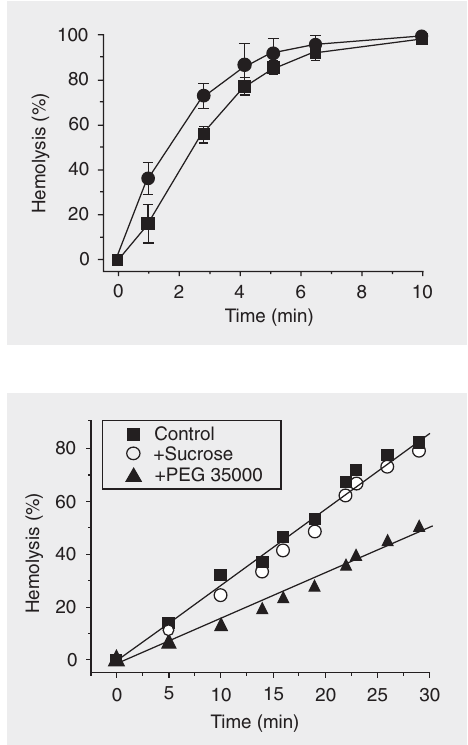
Figure 2. Influence of non-elec- trolytes on the hemolysin activ- ity. The final concentration of hemolysin was 15 µg/ml. Re- sults of typical experiments are presented. Other non-electro- lytes tested (glucose, maltose and low molecule mass polyeth- ylene glycols (PEGs, up to 1000)) had the same negligible effect as sucrose. All other con- ditions are described in Material and